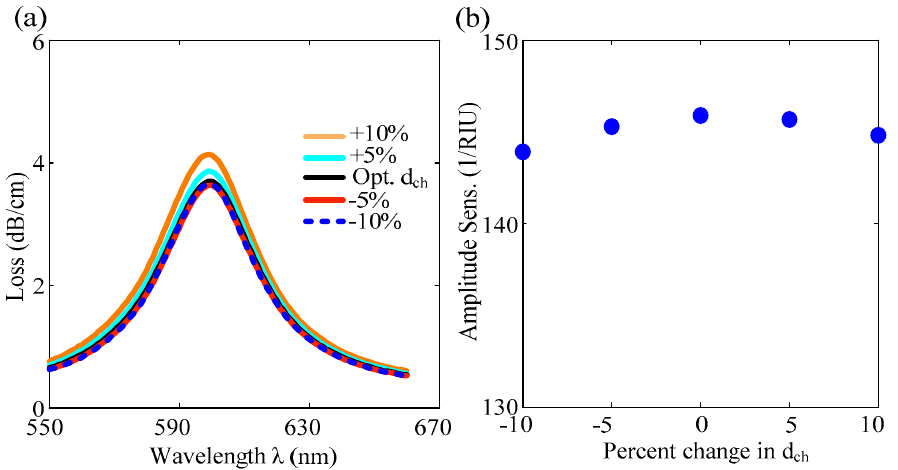
Figure 7. Effect of external channel size: ( a ) loss spectra for different value of d ch , and ( b ) amplitude sensitivities as a function of the percent change in d ch .